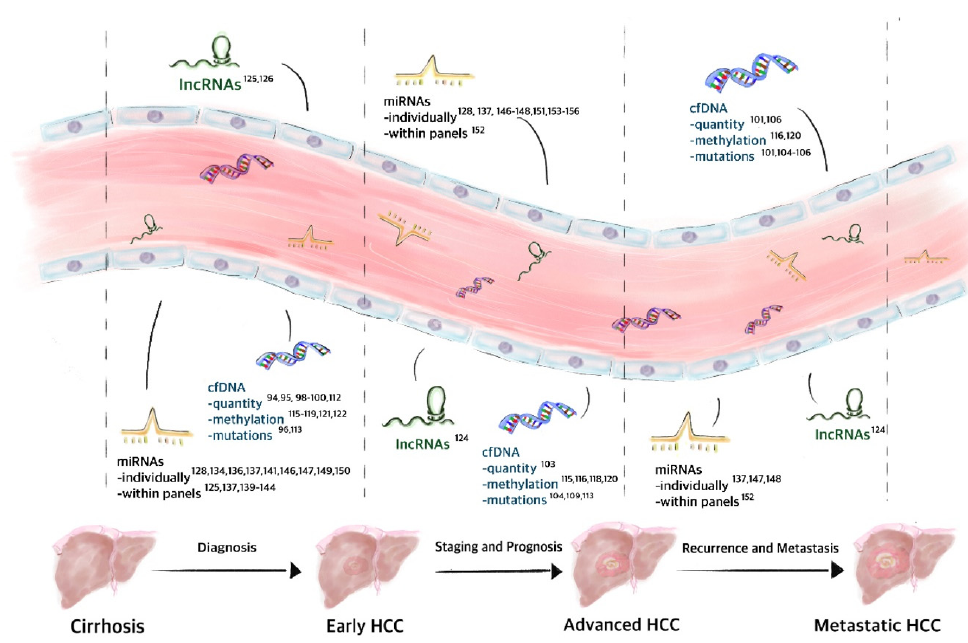
Figure 2. Role of circulating nucleic acids as biomarkers in HCC. Di ff erent types of circulating nucleic acids have already been described as potential biomarkers for the diagnosis and staging of HCC, as well as predictors of progression, recurrence and metastasis, among others, like treatment response. These circulating nucleic acids include lncRNAs; miRNAs used alone or in combinatory panels with other miRNAs or other molecules; as well as the detection of the quantity, hyper / hypomethylation status and di ff erent mutations in cfDNA.